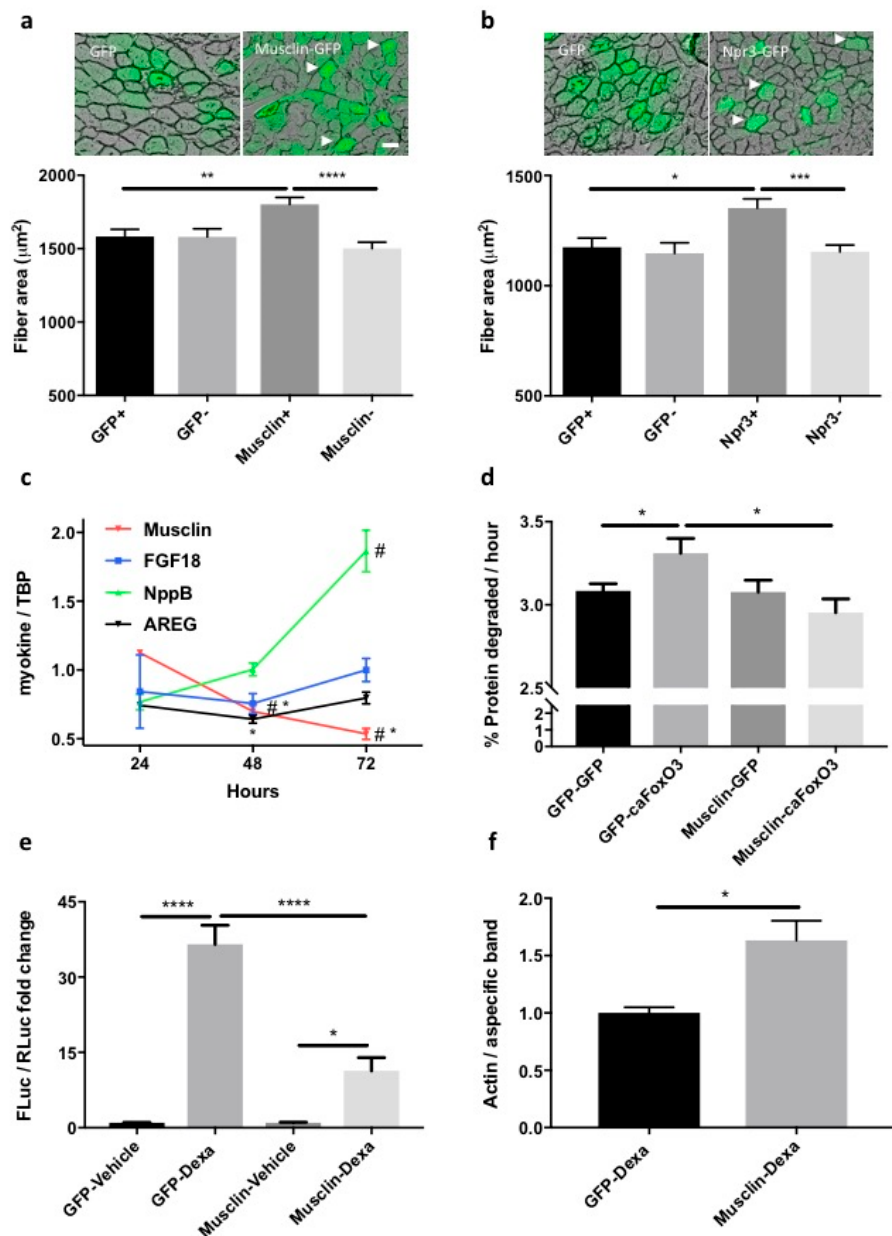
Figure 5. Overexpression of musclin (or its receptor) preserves the fiber area of Tibialis Anterior (TA) during C26 tumor growth in mice, reduces the proteolysis of long-lived proteins in atrophying myotubes, and restrains MuRF1-based signaling in dexamethasone-treated cells. A representative transverse section of fibers electroporated with musclin-GFP-carrying plasmids ( a ) or Npr3-GFP-expressing ones ( b ) from C26-bearing mice is shown. Scale bar, 50 µ m. Arrowheads indicate enlarged fibers as example. The mean cross-sectional area (CSA) of fibers electroporated with the indicated plasmids is plotted for C26-bearing mice, indicating preserved fiber area in musclin or Npr3-expressing fibers ( a , b ). We analyzed 5–6 legs for a total of 102 GFP-expressing fibers and 102 GFP-negative ones, 140 musclin-positive and 140 musclin-negative fibers, 171 Npr3-positive and 171 Npr3-negative fibers. One-way ANOVA followed by Tukey’s test, * p ≤ 0.05, ** p ≤ 0.01, *** p ≤ 0.001, **** p ≤ 0.0001. Myotubes infected for 24, 48 and 72 h with adenoviruses for GFP of caFoxO3 and the expression of the indicated myokines is shown as the fold change over control. Only musclin expression is reduced by